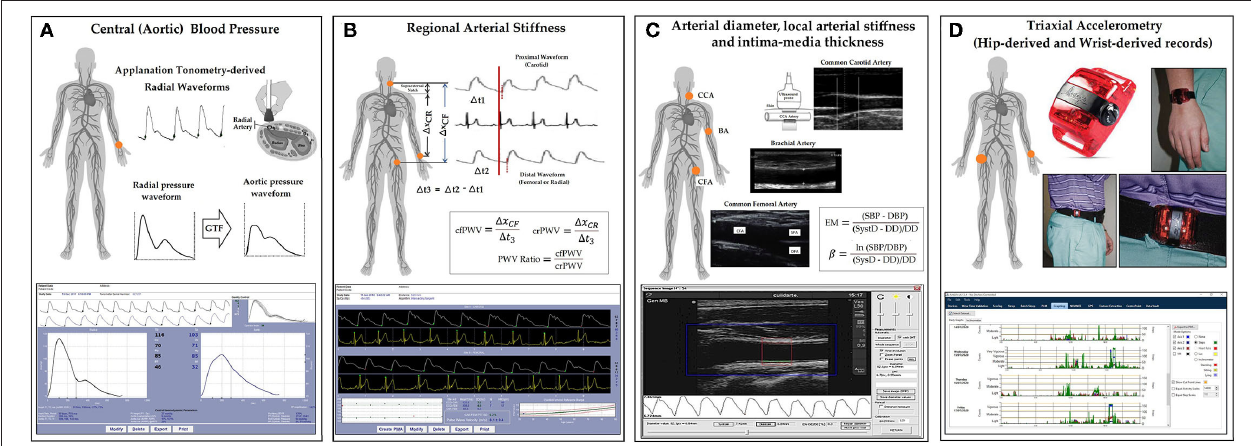
FIGURE 1 | Summary of the non-invasive cardiovascular and accelerometry recordings approach performed on each participant. (A) Central aortic pressure measurements using SphygmoCor device and software (Applanation tonometry). GTF, general transfer function. (B) Regional arterial stiffness measurements using SphygmoCor device and software (Applanation tonometry). 1 xCR and 1 xCF: carotid-radial and carotid-femoral distances. 1 t1 and 1 t2: time between R-wave (QRS) and carotid and femoral “foot wave,” respectively. crPWV, cfPWV: carotid-radial and carotid-femoral pulse wave velocity. PWV, pulse wave velocity. (C) Arterial diameter, local stiffness, and intima-media thickness (IMT) measurements using echography and/or blood pressure measurement using echography and HemoDyn4M software. CCA, CFA, and BA, common carotid artery, common femoral artery, and brachial artery, respectively; EM, elastic modulus; β , beta or stiffness index; SBP and DBP, systolic and diastolic blood pressure; SysD and DD, peak systolic and end-diastolic arterial diameter; (D) Diagram of the placement site of the hip and wrist accelerometers (ActiGraph devices, model GT3X , and ActiLife +